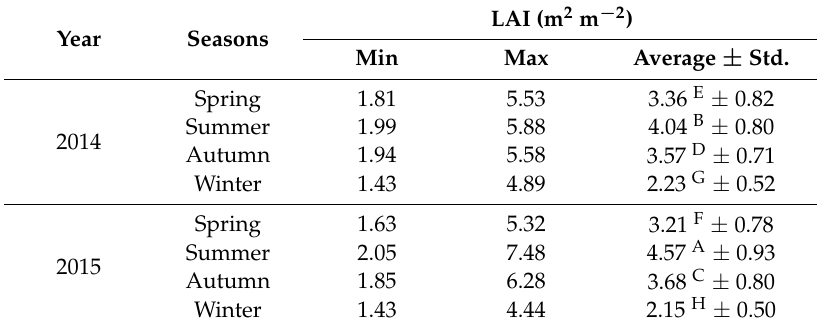
Table 3. Statistical information of bamboo forest LAI assimilated by the PF algorithm in Zhejiang Province. Upper-case letters denote significant differences in each row (one-way ANOVA with Duncan’s multiple range test, p <